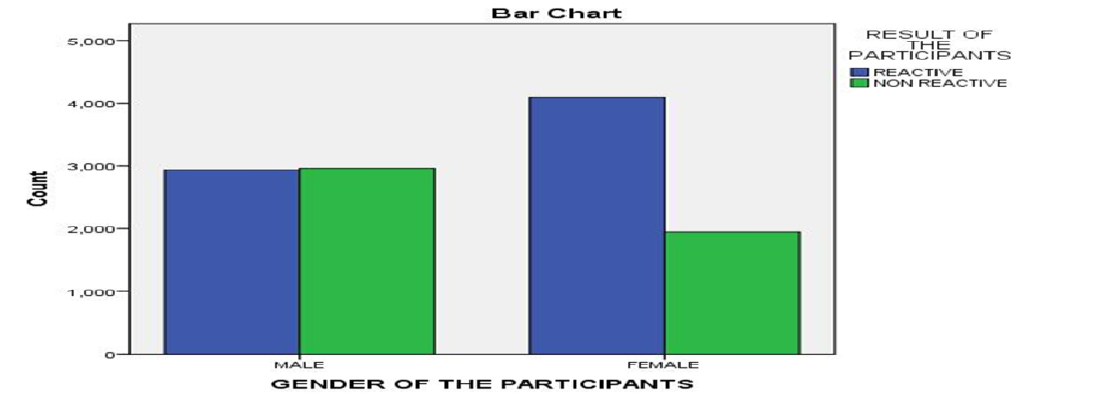
Figure 1. H. pylori sero-positivity values among gender of the study participants